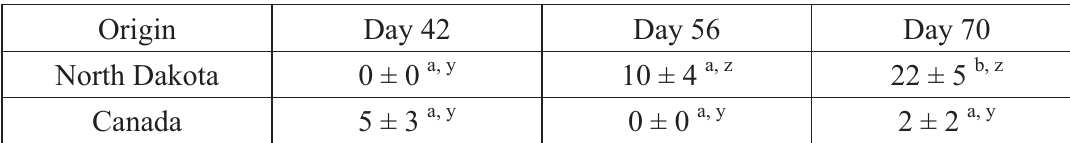
Table 3. Eastern Equine Encephalomyelitis (EEE) titers of weanlings before and after vaccination relative to origin of horse. North Dakota horses had been vaccinated two months previously but their dams had not received pre-natal vaccines. Canadian horses had not been previously vaccinated but their dams had received prenatal vaccinations. Values are means ±